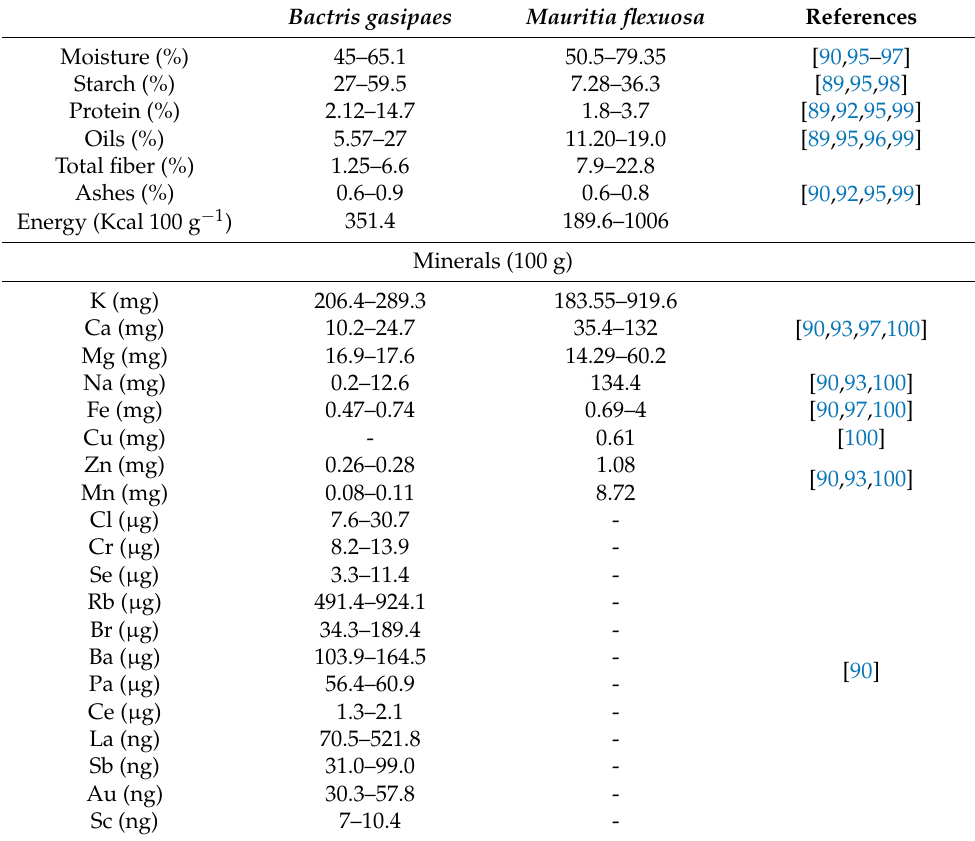
Table 1. Nutritional aspects of peach palm fruit